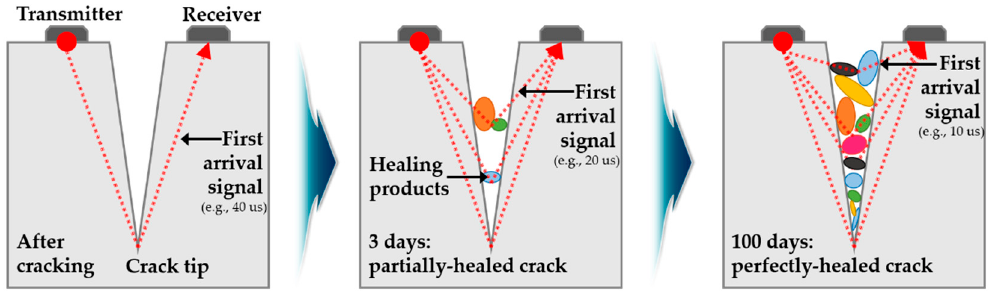
Figure 2. Change in transmission of ultrasonic waves in self-healing process.